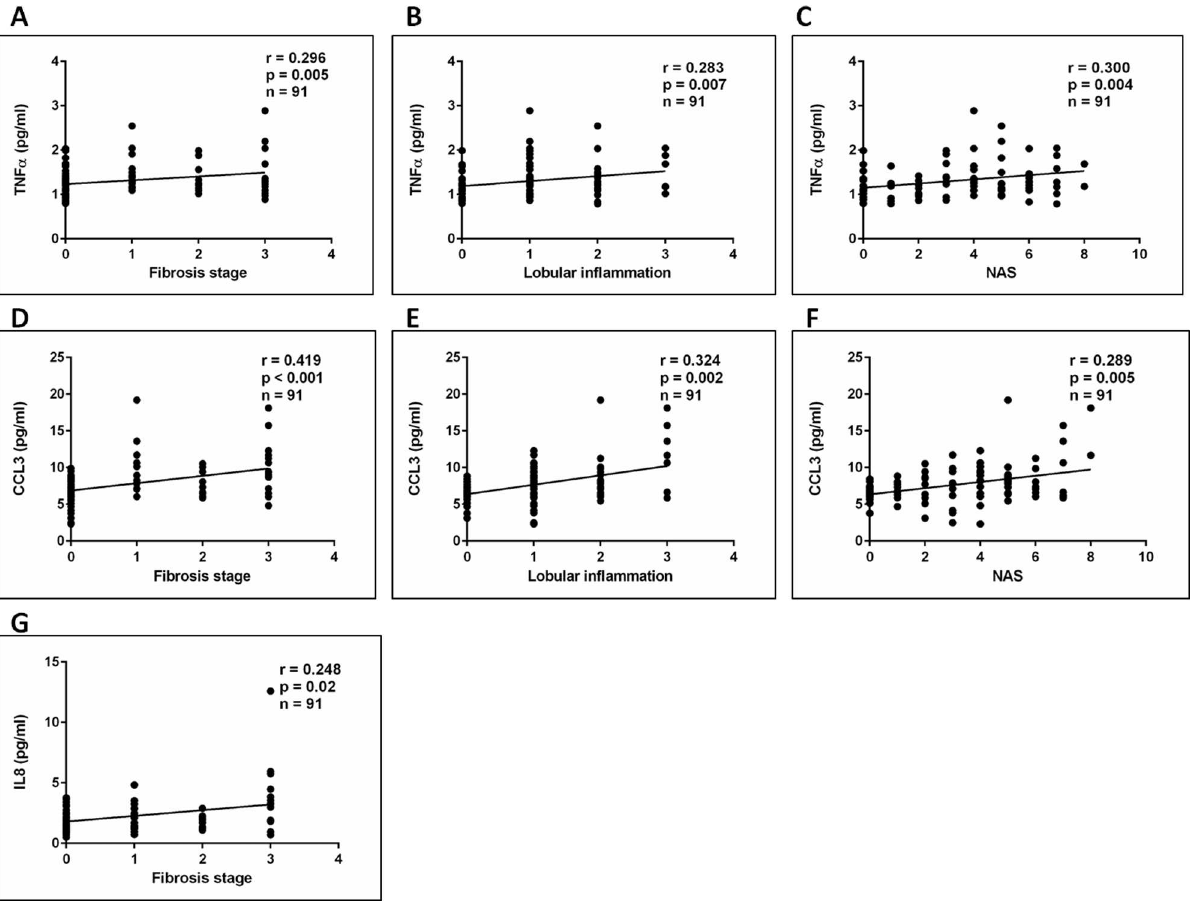
Fig 6. Spearman correlation between plasma levels of inflammatory cytokines and liver histology. Plasma TNF α and CCL3 correlate significantlywith features of liver histology(Fig 6A-6F), such as NAS, lobularinflammation and fibrosis scores, while plasma IL8 levels correlatedwith fibrosis stage (Fig 6G) suggestingthat these inflammatory mediators might be important in NAFLD pathogenesis.